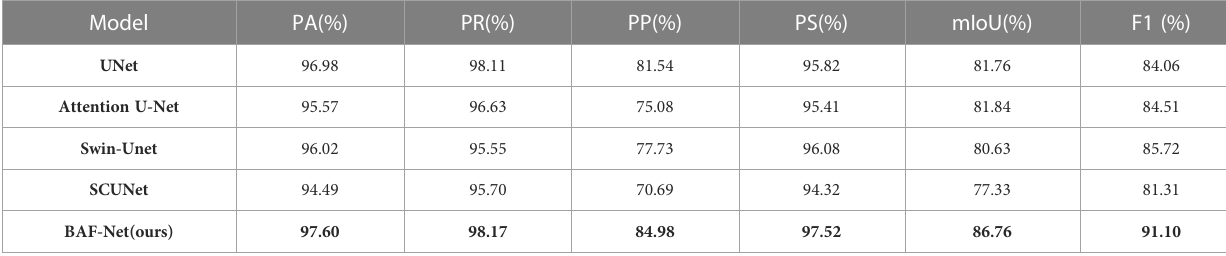
TABLE 4 The segmentation results on the EBD dataset using different models. Model